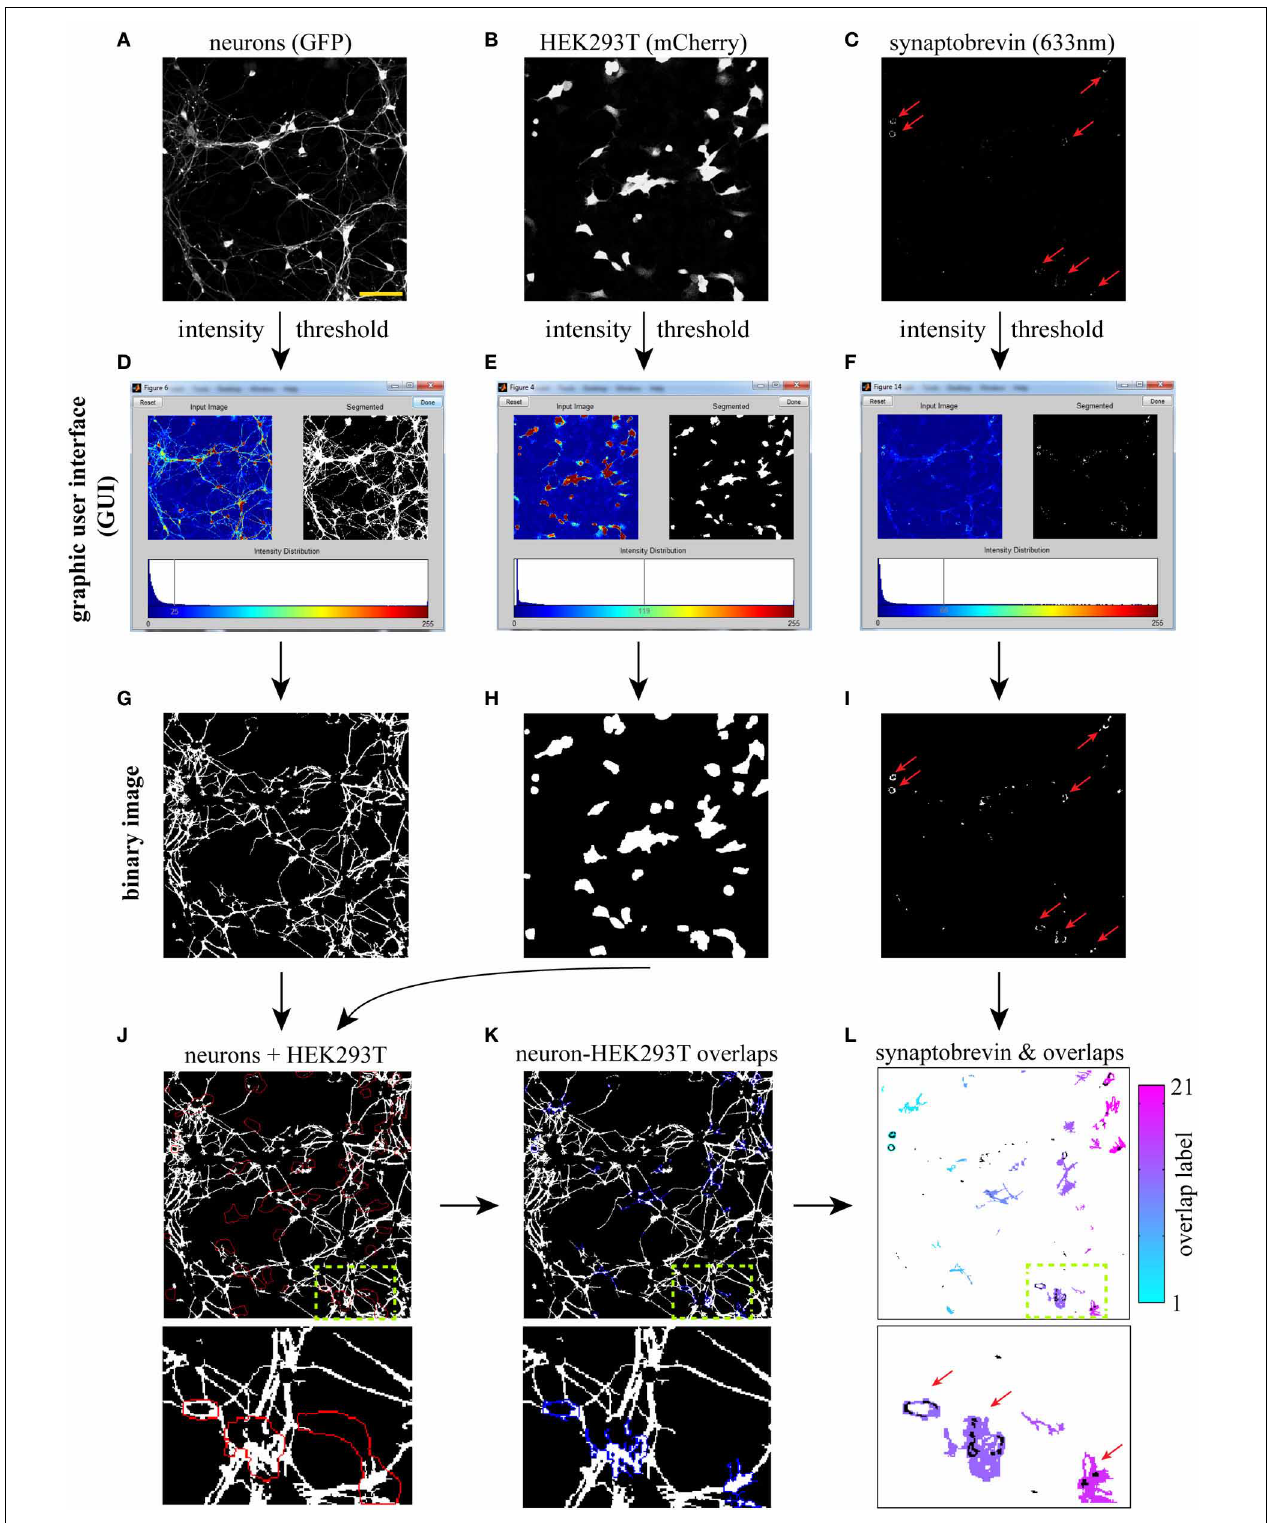
FIGURE 1 | Workflow for computer-assisted segmentation of presynaptic clusters. The three input images (20 × ) (A–C) are binarized using an interactive graphic user interface (GUI, D–F ), and the resulting binary images are cleaned-up (see text) using